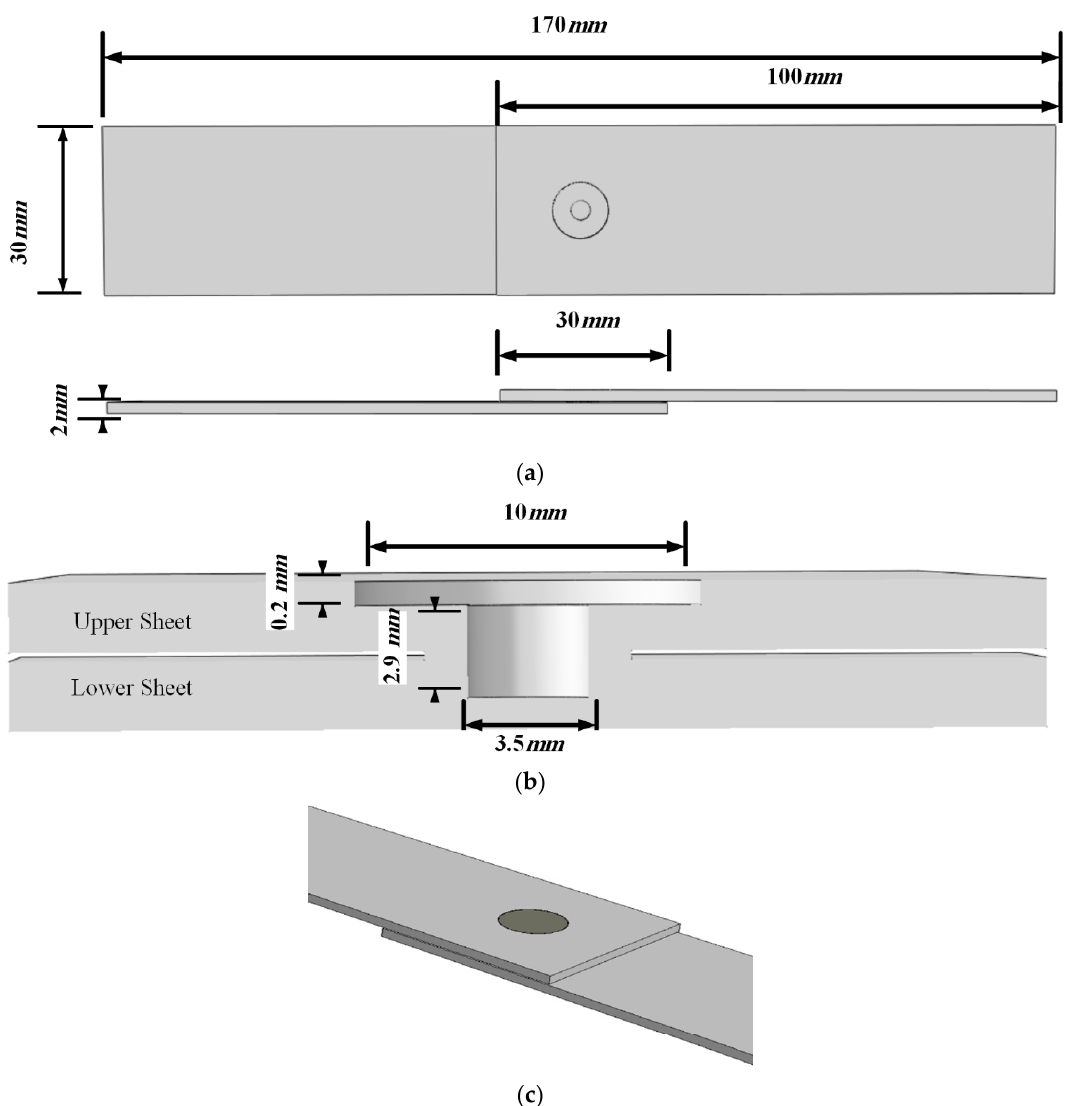
Figure 1. ( a ) Geometry of the specimen made of two sheets overlapping one another, ( b ) geometry of hole, and ( c ) a model with a refilled hole.